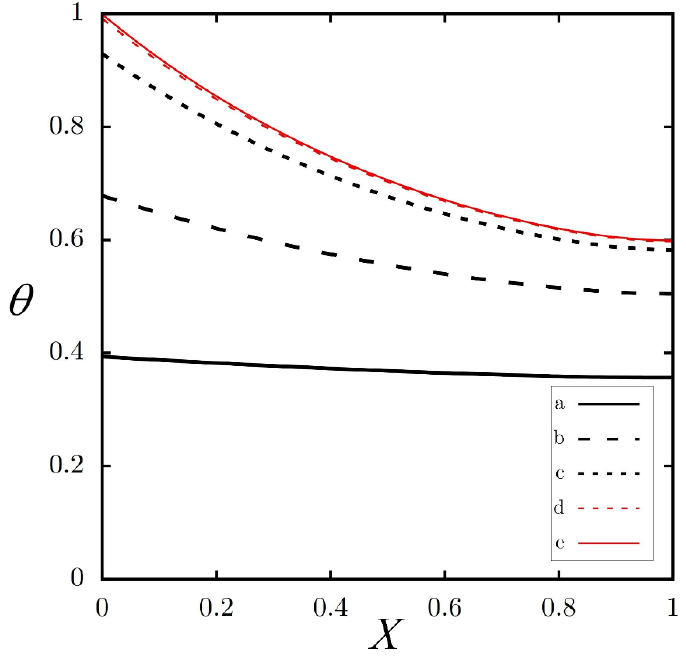
W / k = 1.0 and five values of γ L / k S